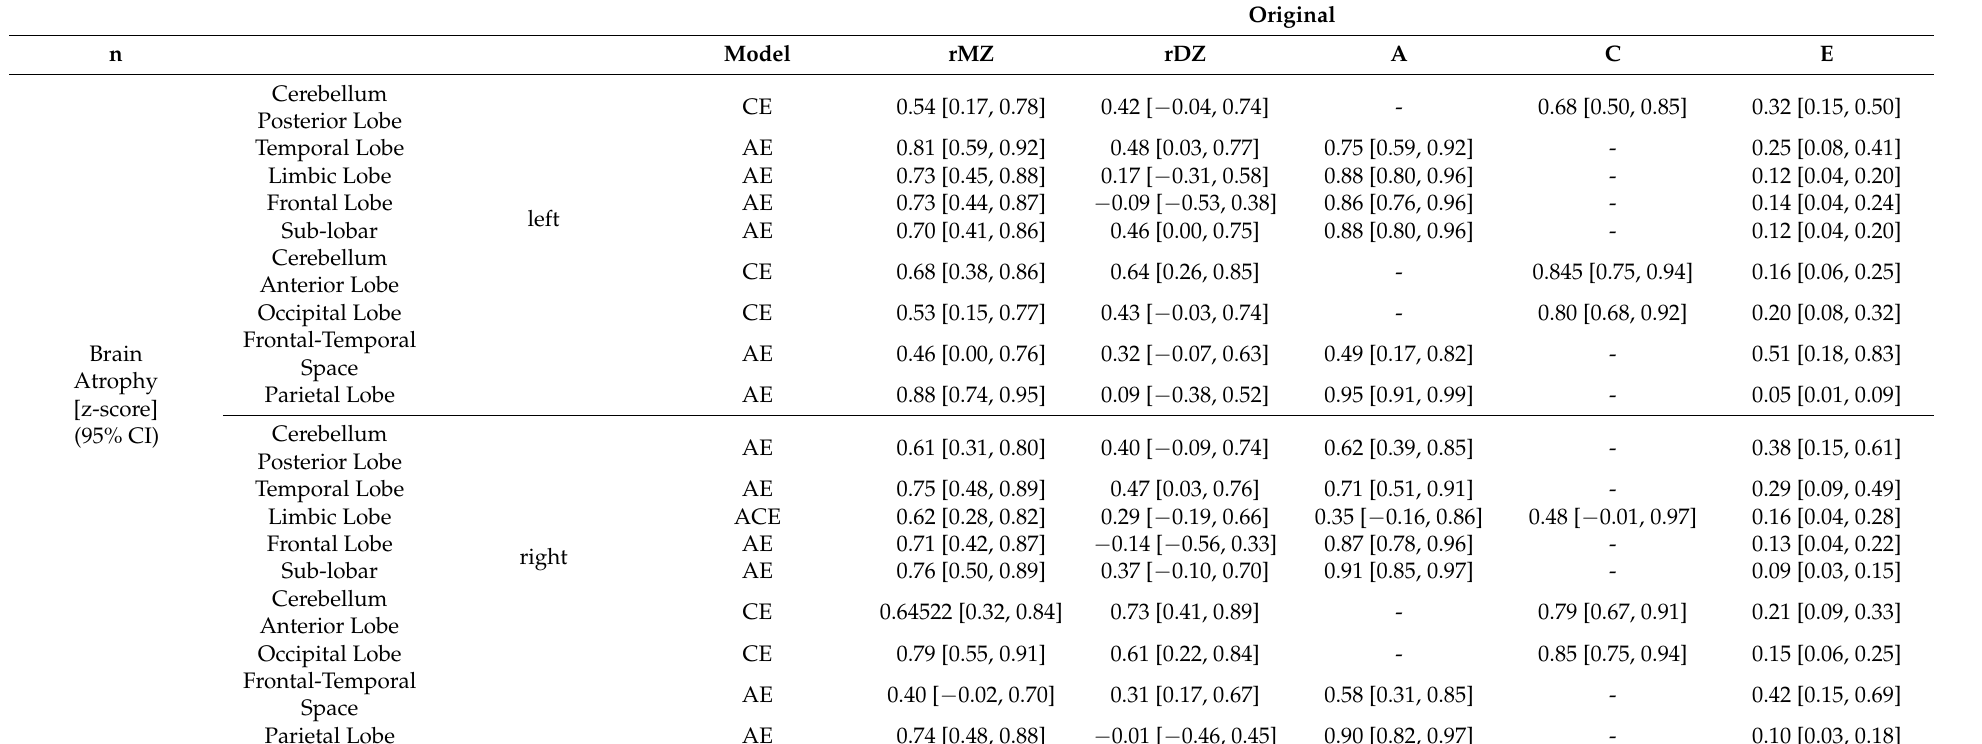
Table 2a. Univariate ADCE model fitting of brain atrophy of the original